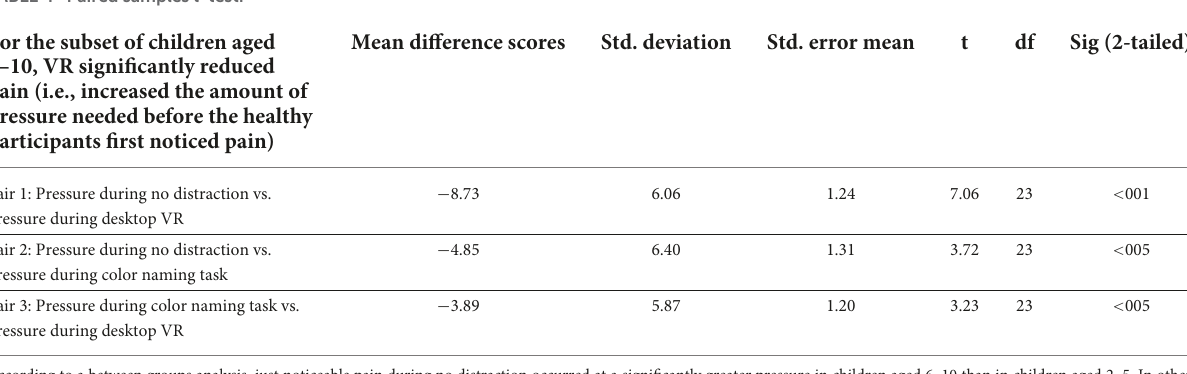
TABLE 4 Paired samples t -test.